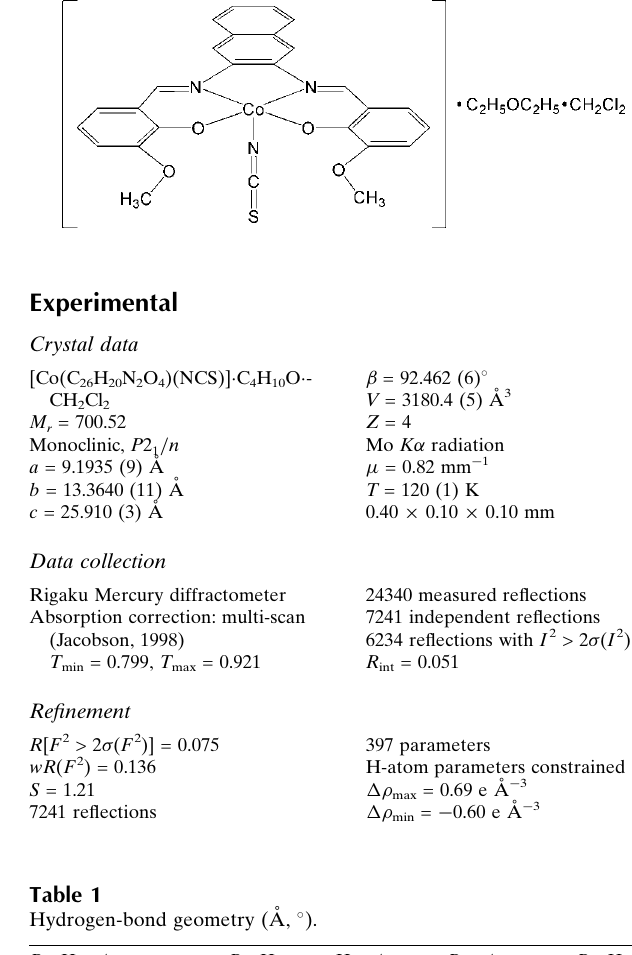
Hydrogen-bond geometry (A˚ , (cid:2) ). D —H (cid:1)(cid:1)(cid:1)